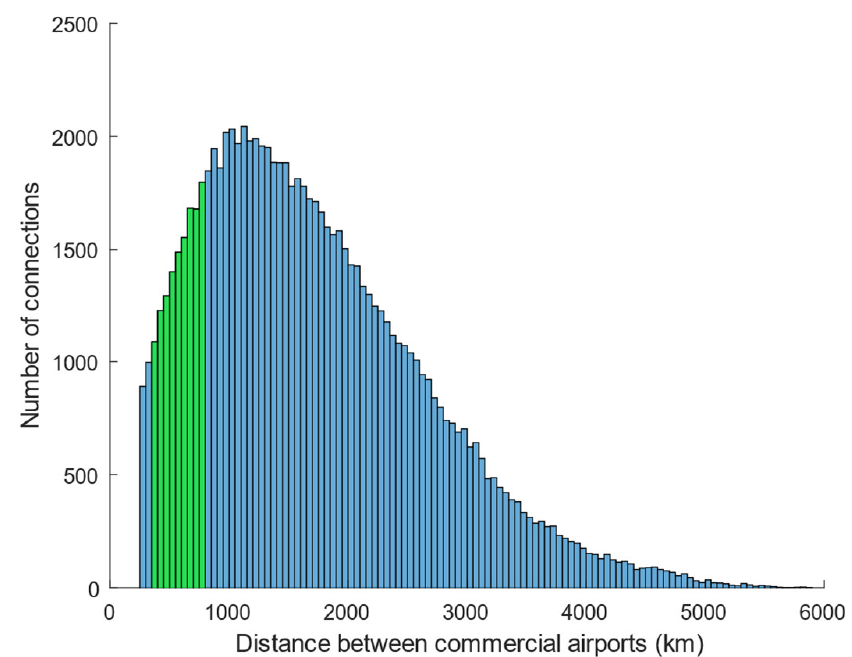
Figure 4. Number and distance of flight connections in the EU (plus Great Britain, Norway, and Switzerland) concerning commercial airports in operation (blue + green)—feasible connections for regional air traffic (green). All connections of more than 6000 km are not displayed. Due to the lower passenger capacity of the planned aircraft, less populated regions could also be connected to the EU traffic network even if there is a lower passenger and cargo volume demand. The availability of these air connections has been shown to play a role regarding regional development [19]. Figure 5 shows the coverage of different ranges for existing commercial airports with a field length of at least 1000 m. It can be seen that nearly all states of the EU can be covered, excluding some islands and overseas